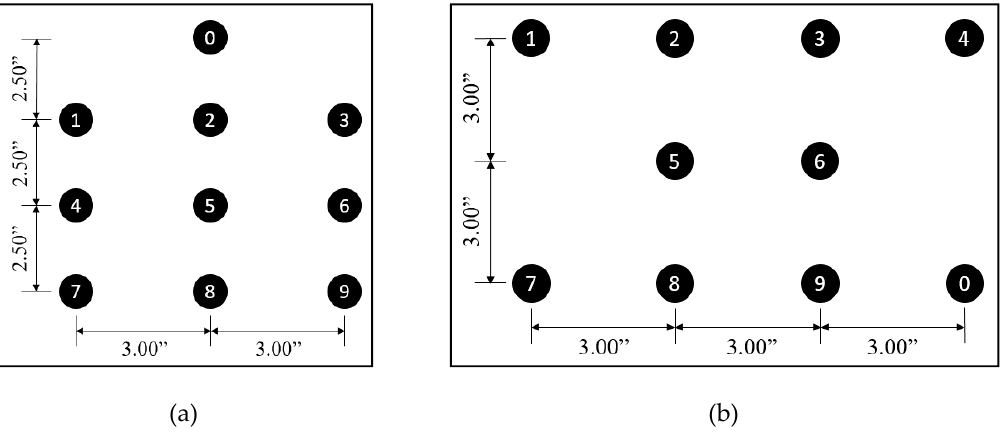
Figure 7. Spacing of vibration motors for preliminary test: ( a ) 1-3-3-3 configuration; ( b ) 4-2-4 configuration.